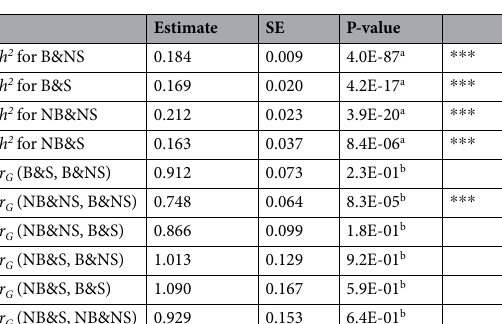
Table 3. The proportion of the phenotypic variance and genetic correlation between the status of breastfeeding and maternal smoking around birth for fluid intelligence. a Testing if the estimate is different from 0. b Testing if the estimate is different from 1; The genetic correlations ( r G ) between NB&NS and B&NS, and NB&NS and B&S are significantly different from 1 as an evidence of G × E. Even after a multiple testing correction (p-value threshold = 0.05/24 = 0.002), these interactions remained significant. *** P-value < 0.001; ** P-value < 0.01; * P-value < 0.05.